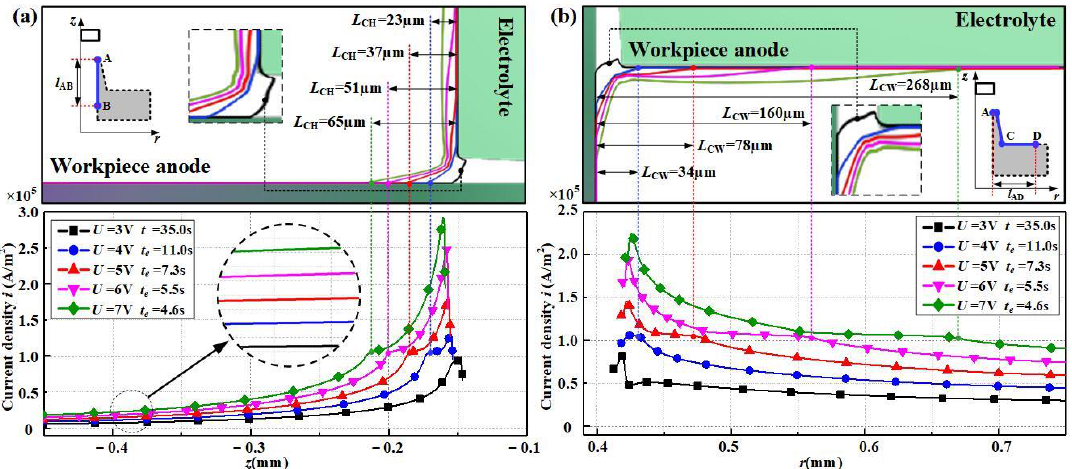
Figure 9. Effect of machining voltage: ( a ) Current density distribution of l AB ; ( b ) Current density distribution of l AD .